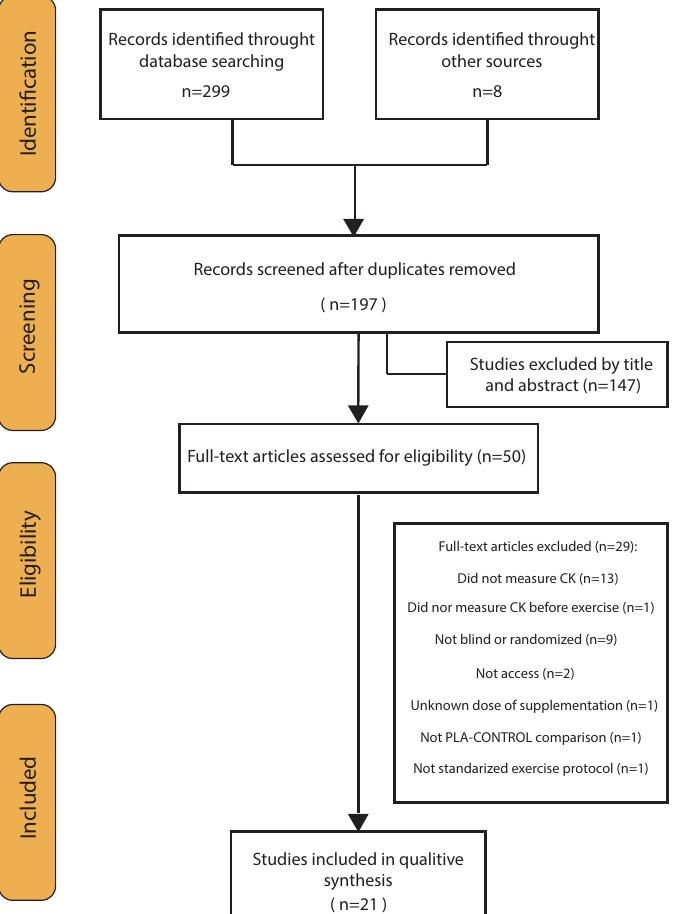
Figure 1. Flow diagram of literature search according to the PRISMA